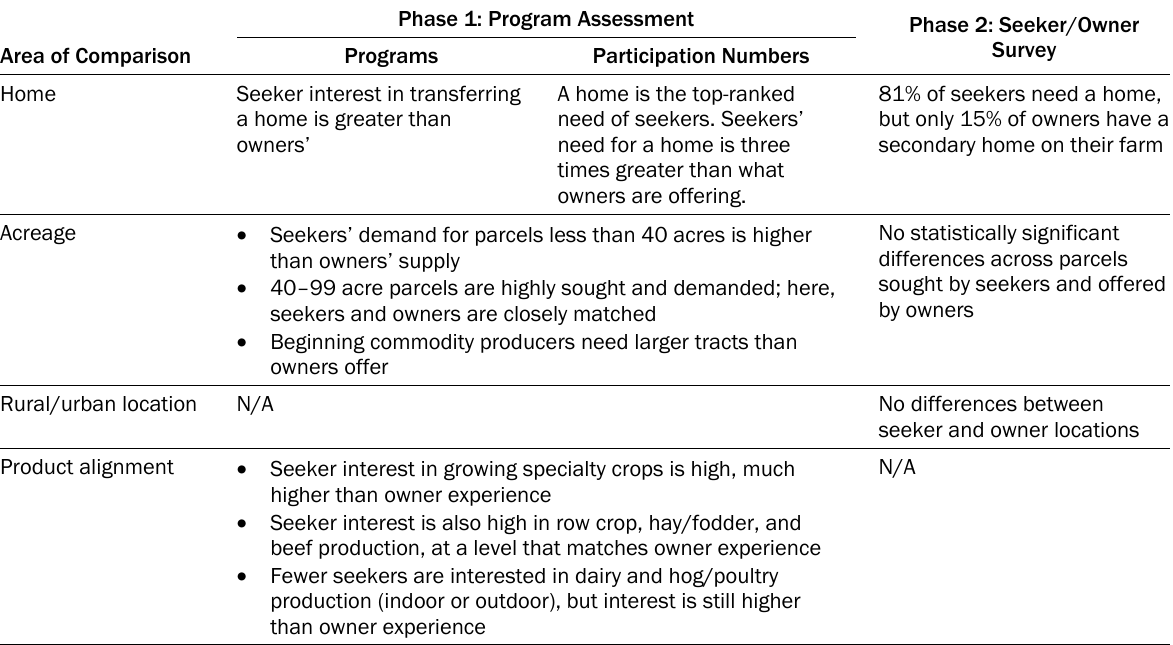
Table 3. Summary of Findings by Study Phase, Analytical Approach, and Area of Comparison